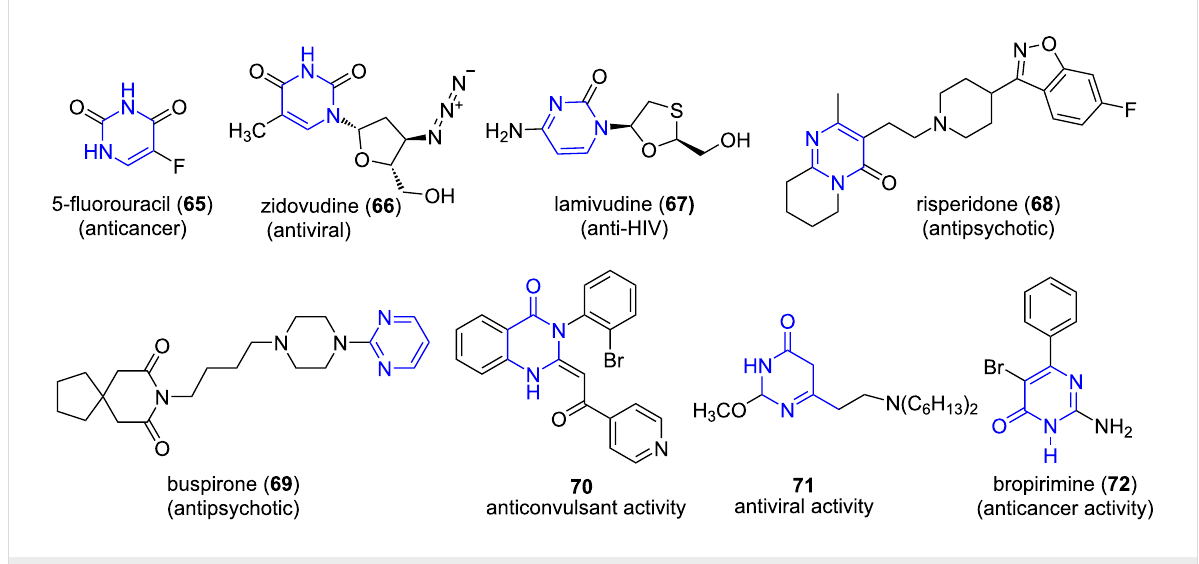
Figure 6: Marketed drugs and molecules containing pyrimidine and pyrimidinones skeletons.